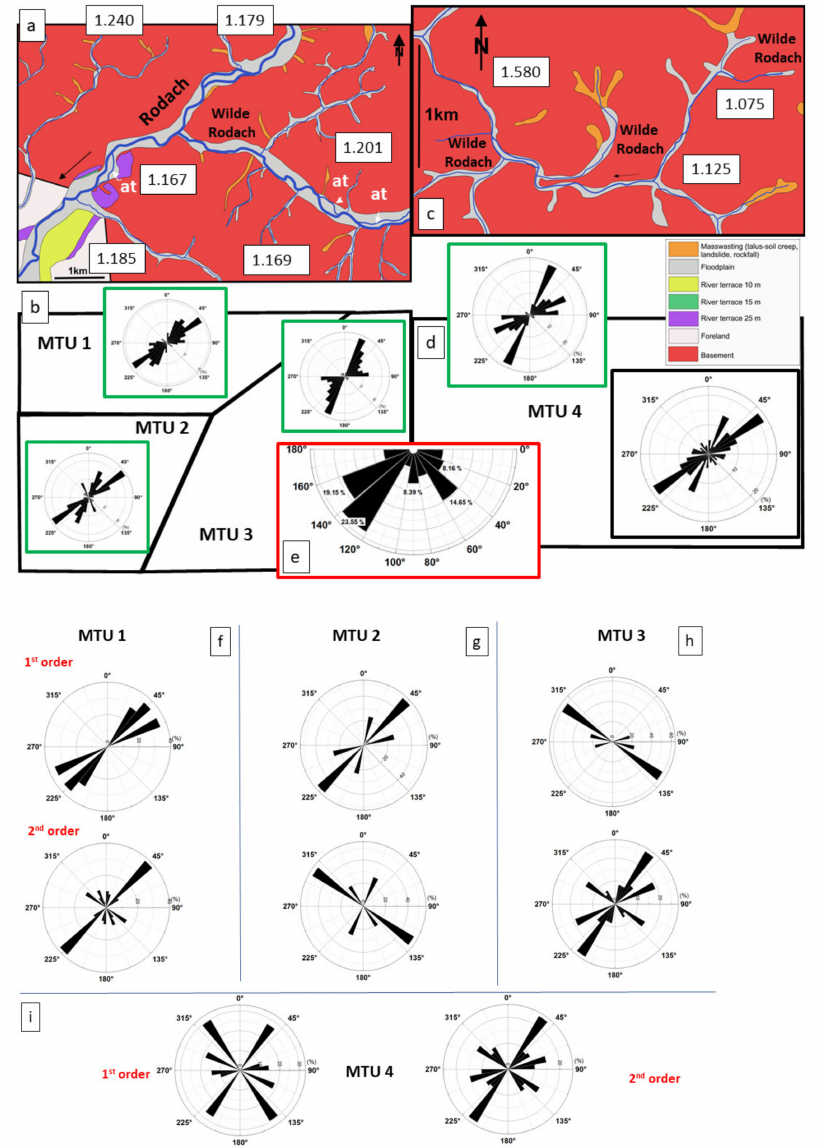
Figure 8. Litho- and morphotectonic units (MTU) characterized by the sinuosity of drainage systems (rectangular boxes) and the structural geology of the bedrock in VLG-type (see Figure 3). Fold structures ( a – e ) in full-circle rose diagram framed in green shows the cleavage and full-circle rose diagram framed in black shows the main fault zones (520 data). ( a ) DA and TA of the VLG-type drainage systems; ( b ) Tectonic datasets for ( a ) (MTU 1, MTU 2 and MTU 3); ( c ) TA and CA of the VLG-type drainage systems; ( d ) Tectonic dataset for ( c ) (MTU 4); ( e ) Composite semicircle rose diagram showing the orientation and frequency of faults in the Frankenwald within the Teuschnitz Syncline and the Berga Anticline (Figure 1b); ( f ) Orientation of 1st and 2nd order fluvial channels of MTU 1 (percentage of total length of the drainage system); ( g ) Orientation of 1st and 2nd order fluvial channels of MTU 2 (percentage of total length of the drainage system); ( h ) Orientation of 1st and 2nd order fluvial channels of MTU 3 (percentage of total length of the drainage system); ( i ) Orientation of 1st and 2nd order fluvial channels of MTU 4 (percentage of total length of the drainage